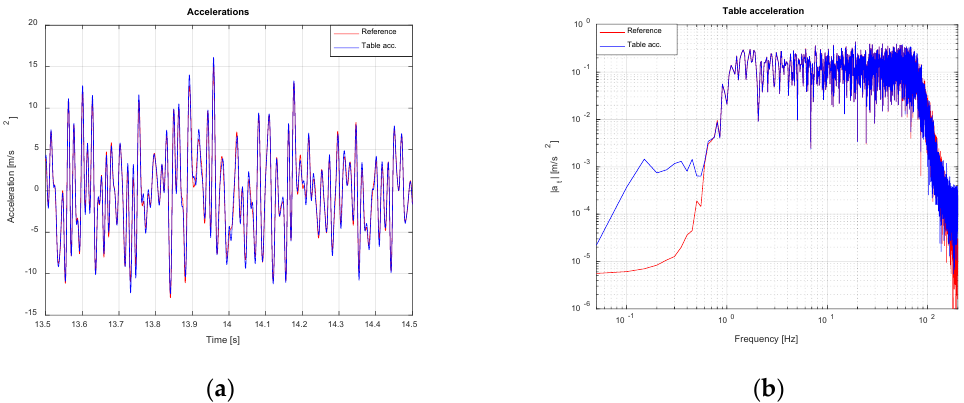
Figure 23. Shake table acceleration tracking (noise-contaminated scenario). TVC Enabled: ( a ) Time domain; ( b ) Frequency domain.